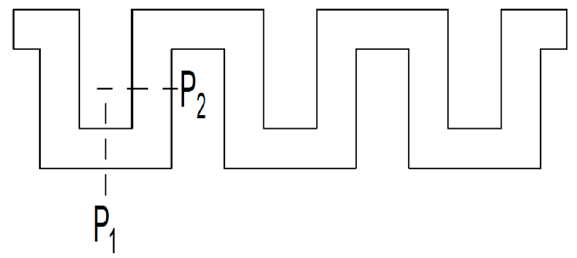
Figure 9. Streamlined diagram of the C 1 emitter.